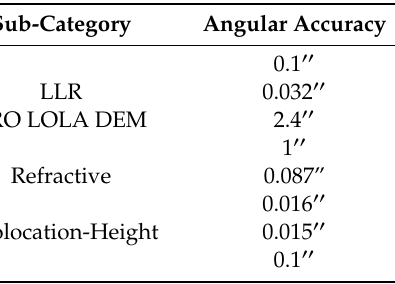
Table 3. Estimated